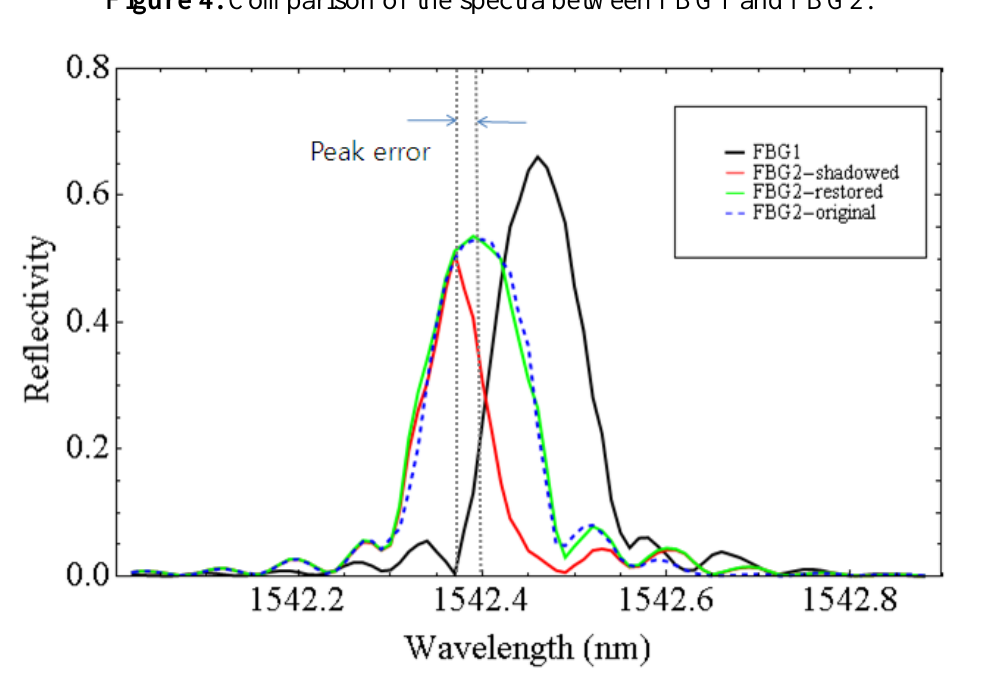
Figure 4. Comparison of the spectra between FBG1 and